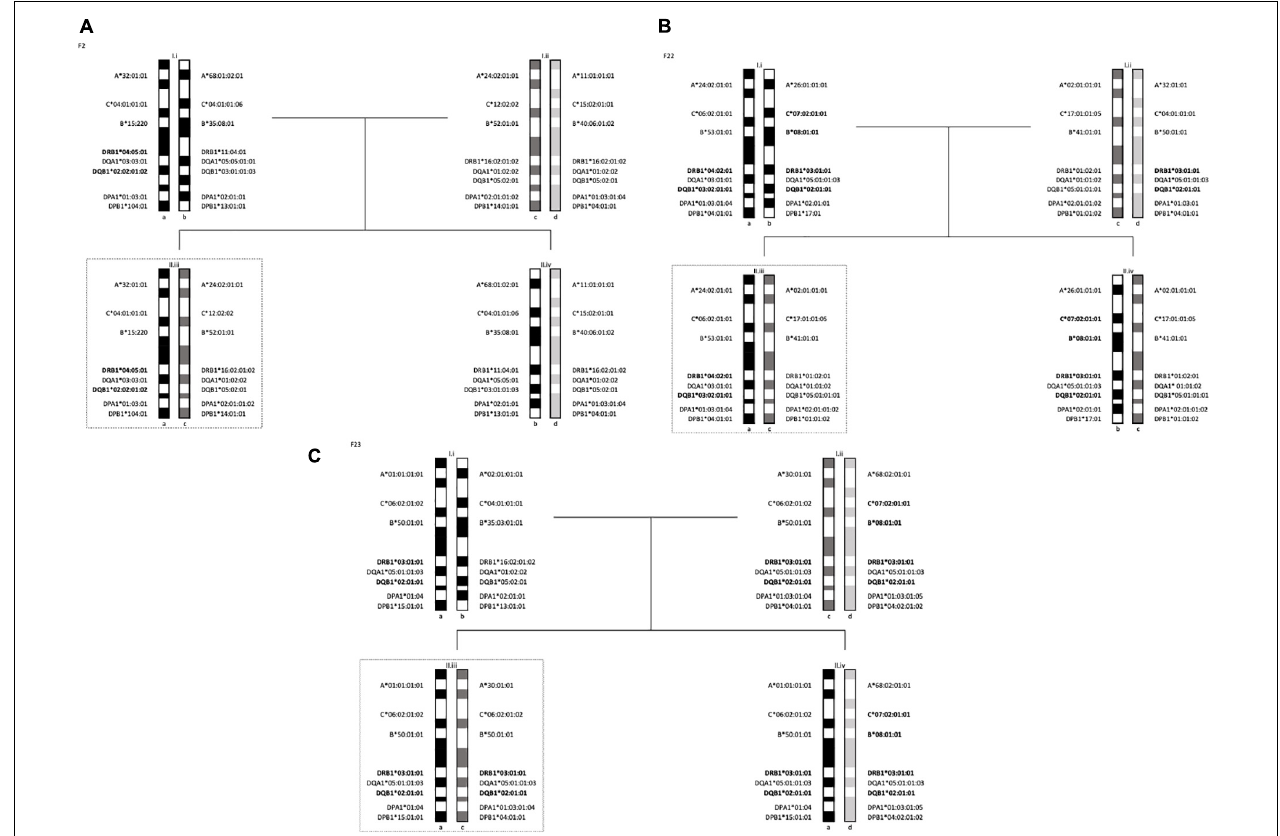
FIGURE 1 | Segregation analysis of the 5 families with one T1D subject showing the MHC long-range haplotypes. In dotted lines are offsprings diagnosed with T1D. (A) Family 2 haplotypes, II.iii is diagnosed with T1D. (B) Family 22 haplotypes, II.iii is diagnosed with T1D. (C) Family 23 haplotypes, II.iii is diagnosed with T1D.